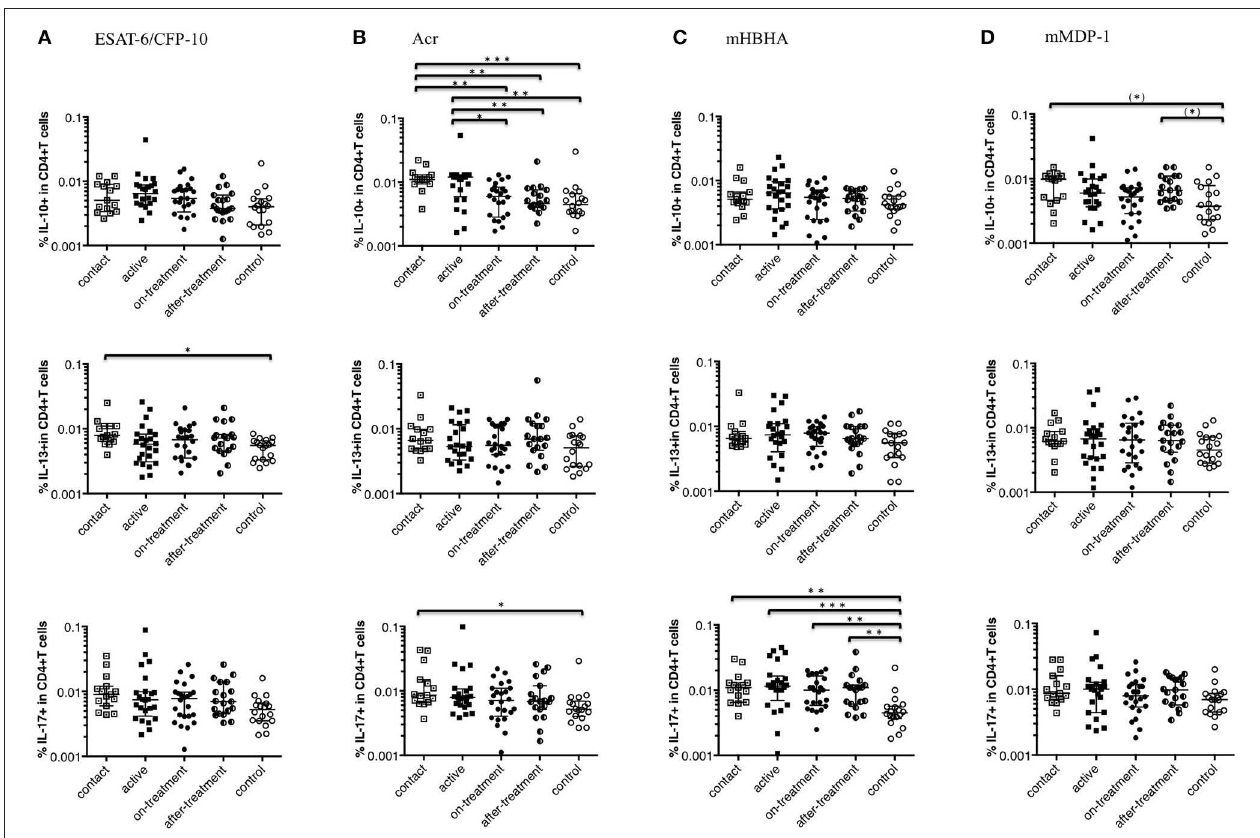
FIGURE 2 | Non-Th1 cytokine (IL-10, IL-13, and IL-17) responses of CD4 + T cells to M. tuberculosis -associated antigens. Non-Th1 cytokine responses of CD4 + T cells in M. tuberculosis -infected cases, grouped according to the disease stage as active TB cases ( n = 24), on-treatment TB cases ( n = 24), after-treatment TB cases ( n = 19), and contact cases ( n = 15). Responses of control cases ( n = 18) are also shown. The differences between each set of samples were assessed using the Kruskal-Wallis test and post-hoc Dunn’s Comparison test (* P < 0.05, ** P < 0.01, *** P < 0.001). (*) means the possible differences of preselected pairs (* P < 0.05). The long horizontal line represents the median and the vertical line represents the interquartile range. (A) Non-Th1 cytokine responses to ESAT-6/CFP-10 (Three data points are outside the limits in IL-10, and also three data points are outside the limits in IL-13). (B) Non-Th1 cytokine responses to Acr (Three data points are outside the limits in IL-10, and also three data points are outside the limits in IL-13). (C) Non-Th1 cytokine responses to methylated (m) HBHA. (D) Non-Th1 cytokine responses to mMDP-1 (One data point is outside the limits in IL-10, one data point is outside the limits in IL-13, and one data point is outside the limits in